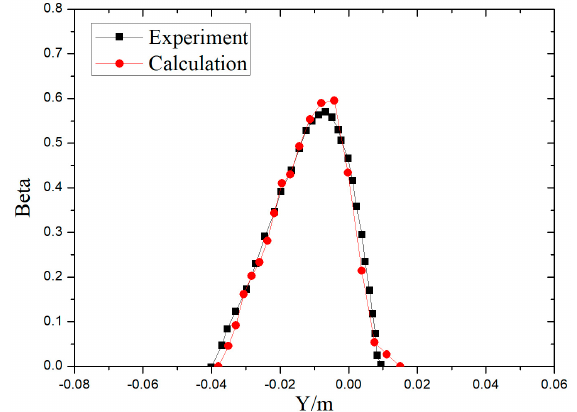
Figure 4. Comparison of collection coe ffi cients for the NACA0012 veri fi cation example.